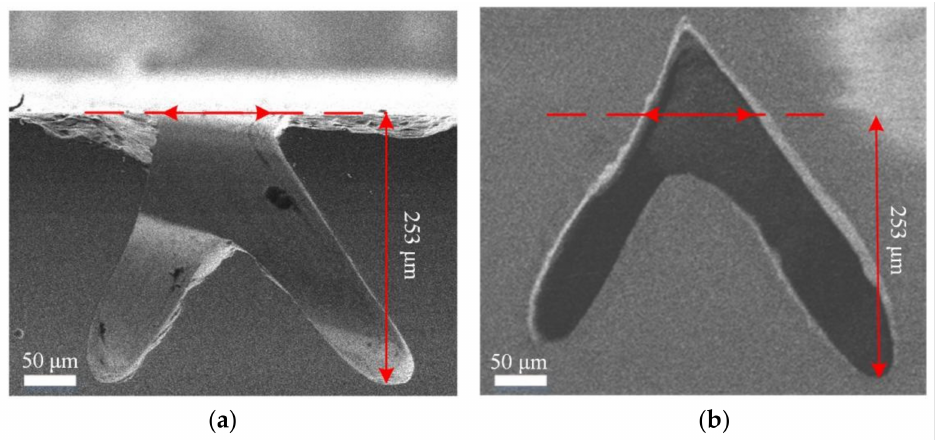
Figure 4. ( a ) SEM image of reverse-V-shaped microchannel; ( b ) After